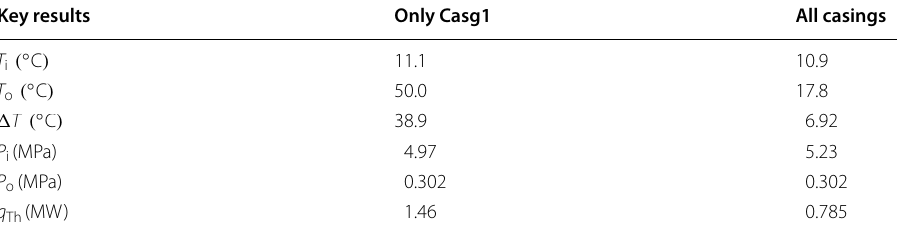
Table 9 Key results comparing insulating properties for only Casg1 and for all casings to